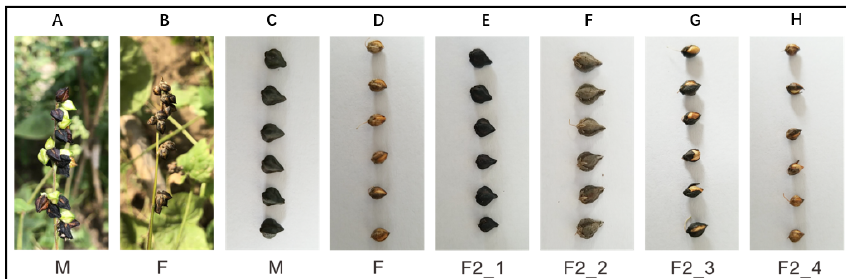
Figure 1. Phenotype of traits associated with the dehulling: ( A ) seed loading branch of Tartary buckwheat as male parent; ( B ) seed loading branch of rice-Tartary as female parent; ( C ) seeds of Tartary buckwheat as male parent; ( D ) seeds of rice-Tartary as female parent; ( E ) “Tartary-buckwheat-like” seeds in the F2 population; ( F ) “Tartary-buckwheat-like” seeds in the F2 population; ( G ) “rice-Tartary-like” seeds in the F2 population; and ( H ) “rice-Tartary-like” seeds in the F2 population.